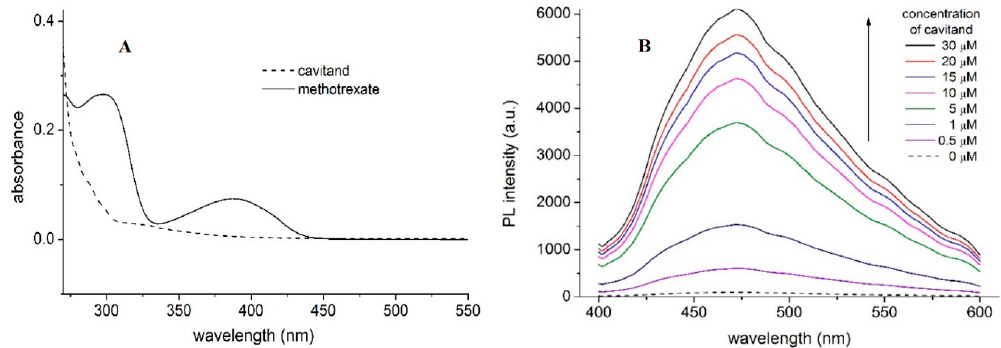
Figure 2. Absorption spectra of MTX (10 µM) and TAC (10 µM) ( A ) and fluorescence emission spectra of MTX (10 µM) in the absence and presence of TAC (0–30 µM) at 393.15 K ( B ) PL and a.u. reflect photoluminescence and arbitrary units, respectively.